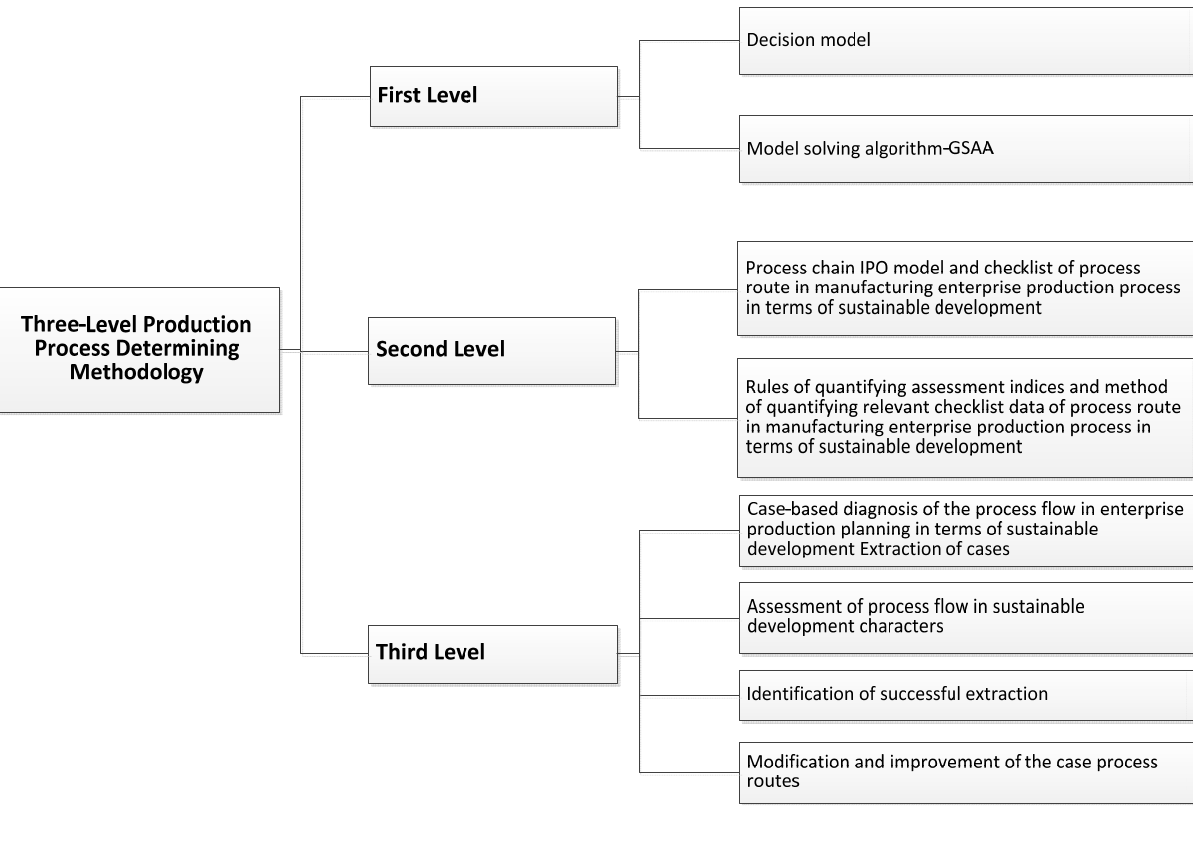
Figure 3. Architecture of the methodology for determining a three-level production